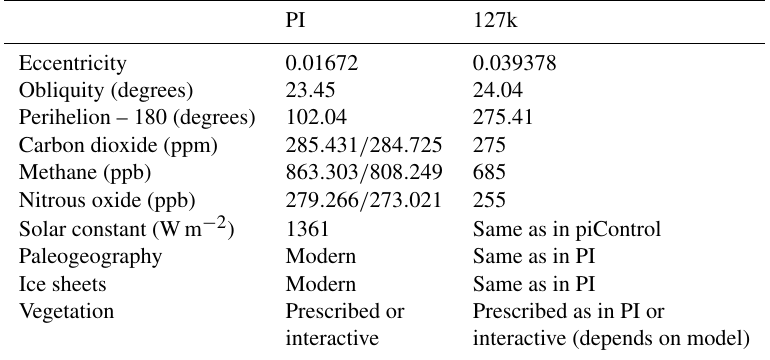
Table 1. Forcings and boundary conditions of the pre-industrial (PI) and last interglacial (127k). Greenhouse gas levels for MIROC-ES2L are shown in the PI